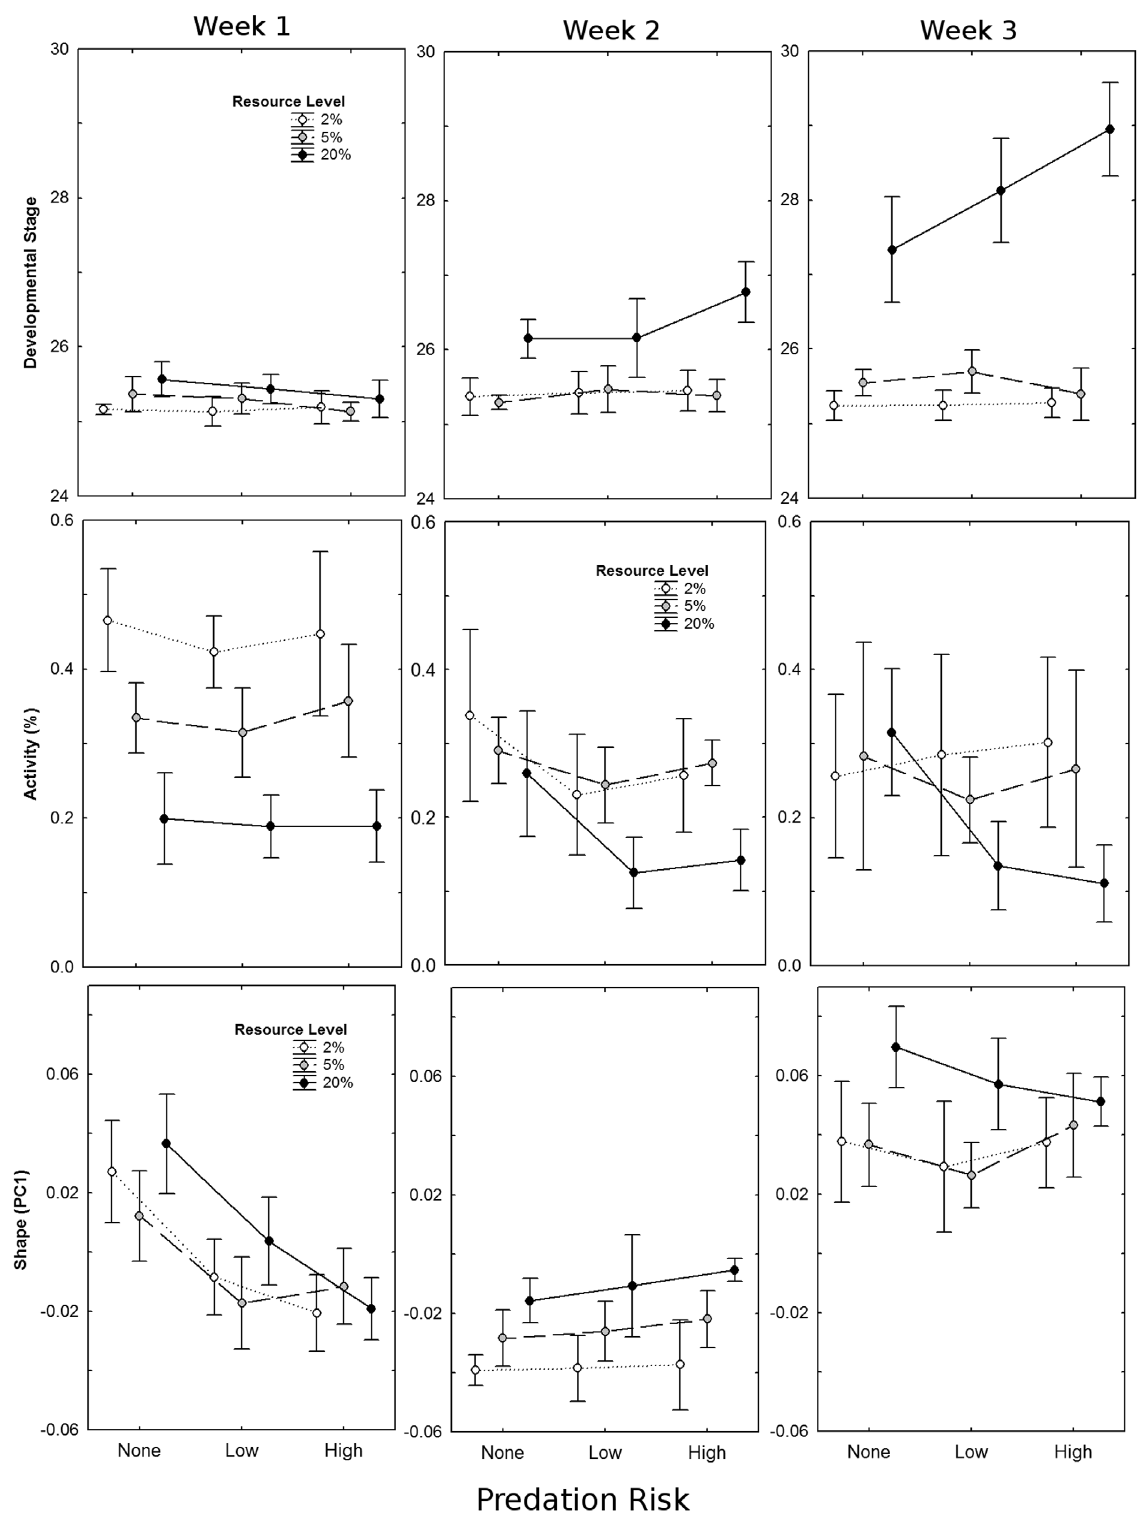
Figure 3. Interaction plots of resource level (2%: severe restriction, 5%: moderate restriction, 20%: saturation) and predation risk (none, low, high) on mean ( ± 95% CI) developmental stage (top), activity (proportion of active tadpoles per aquarium; middle), and shape (PC1; bottom) of Northern leopard frog ( Lithobates pipiens ) tadpoles averaged by week, across three weeks of experimentation.